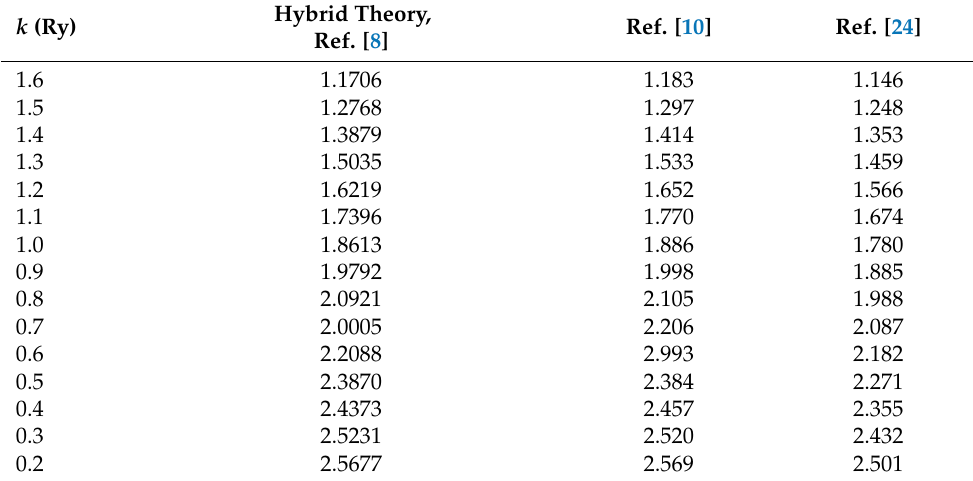
Table 4. Photoionization cross sections (Mb) of the ground state (1s1s) 1 S of Li +.